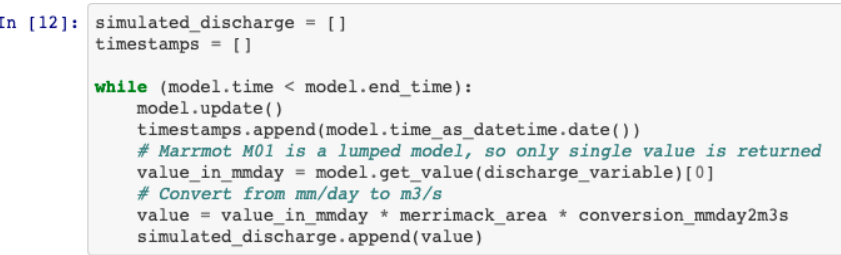
Figure 6. Snippet from the code that generated the hydrograph in Fig. 5. Each time model.update() is called, the eWaterCycle platform instructs the hydrological model running in a container to run for one time step. After each update the user can interact with the state of the model, which in this simple example allows them to extract the calculated discharge at every time